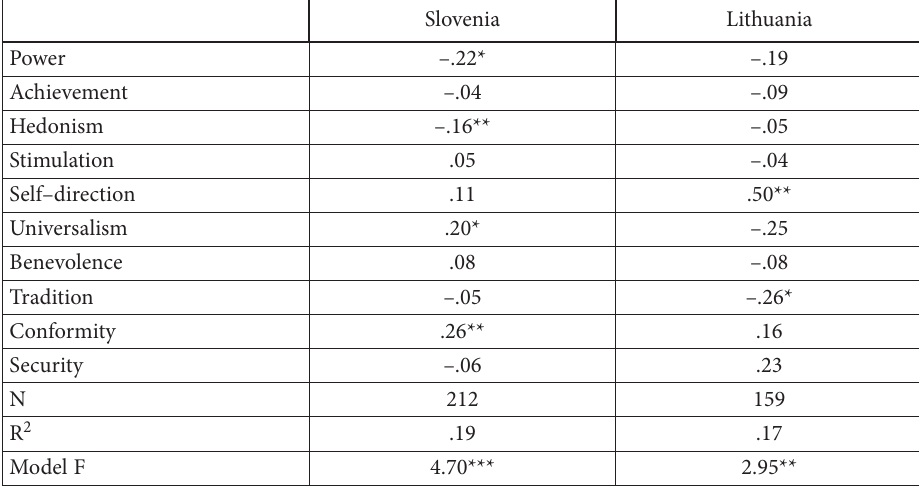
Table 6. Regression analysis results for the impact of personal values on self-indulgent behavior (cre- ated by the authors) Slovenia